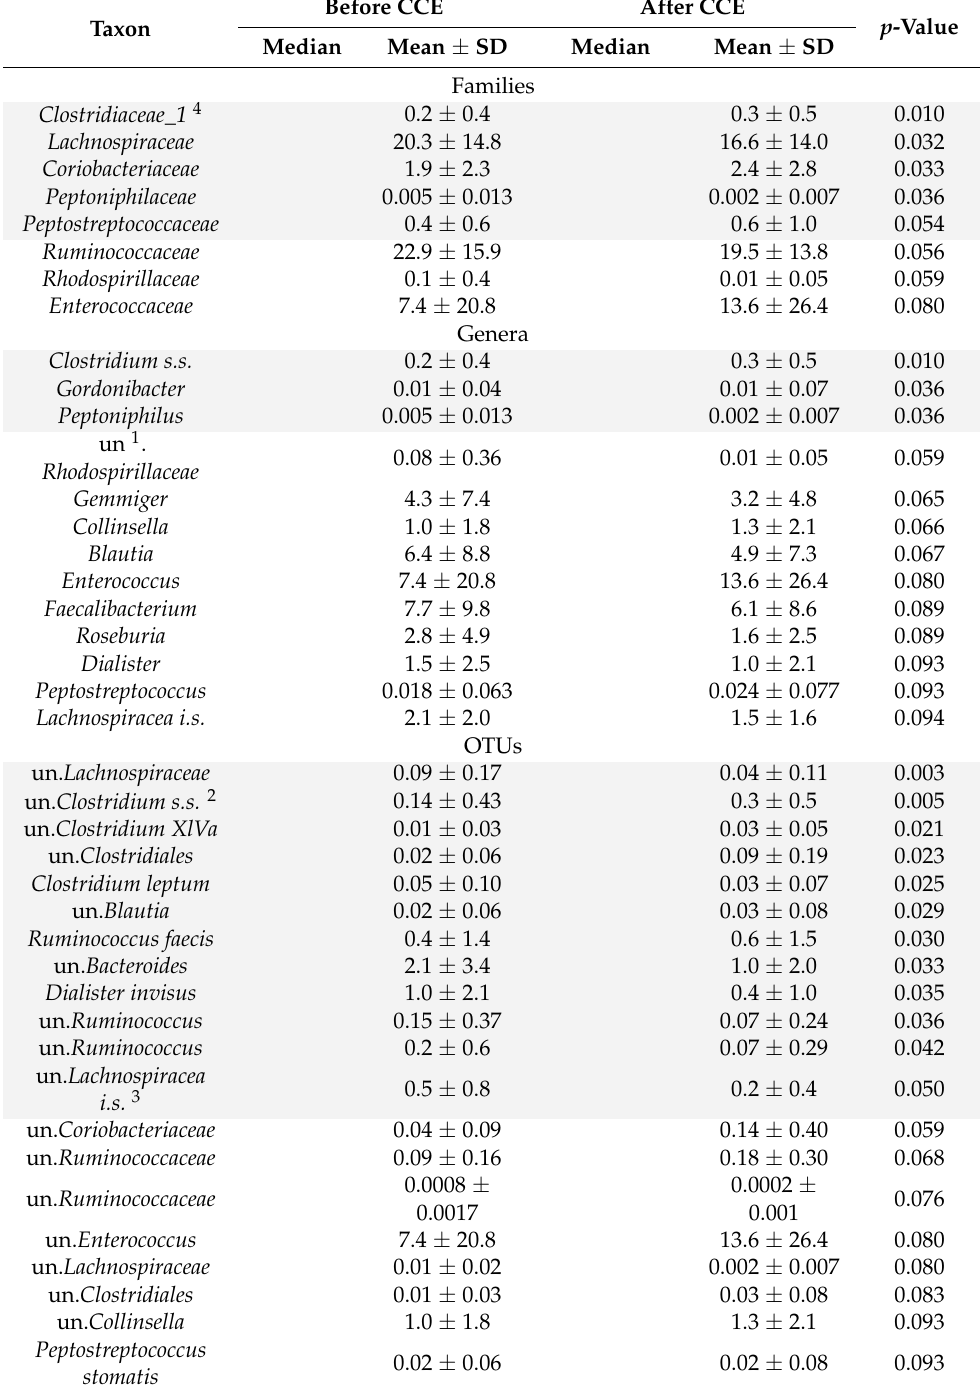
Table 6. The relative abundance of some bacterial families, genera and OTUs in patients’ feces before and after